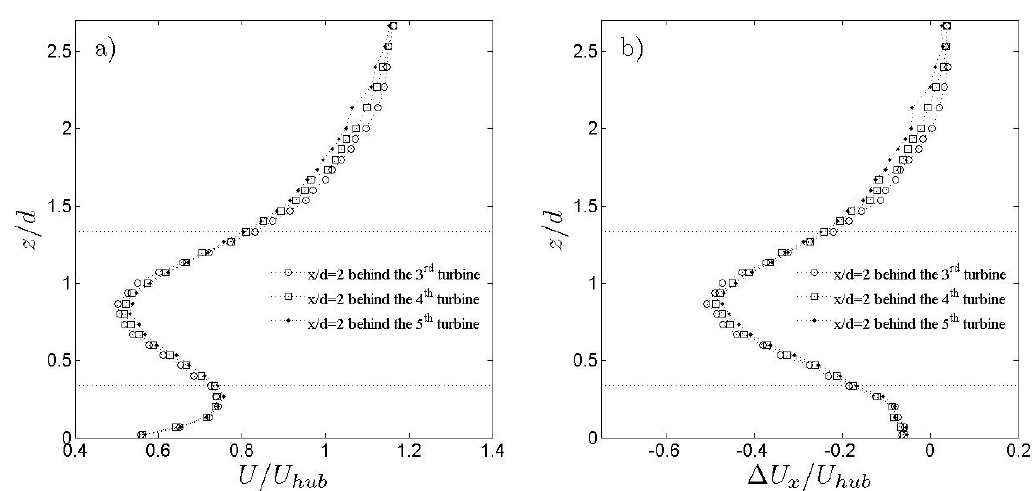
Figure 3. Normalized streamwise velocity component distribution ( left ) and its deficit ( right ) in the wind